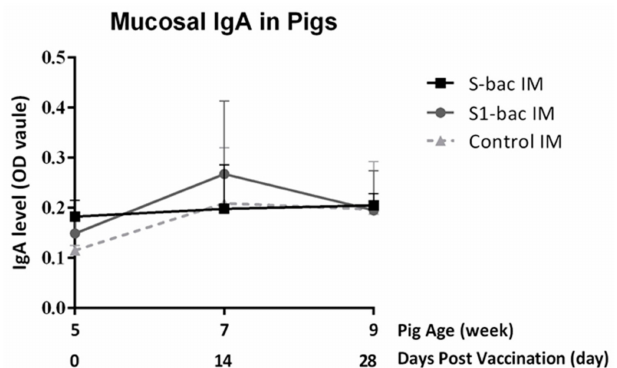
Figure 6. The systemic anti-porcine epidemic diarrhea (PEDV) spike (S)-specific IgG levels in piglets after S-Bac or S1-Bac vaccination. The systemic IgG levels of piglets were detected every two weeks at day 0 (pre-priming), day 14 (2 weeks post-priming) and day 28 (2 weeks post-boosting) by using the PEDV S-based ELISA. The data is shown as the mean values of the sample-to-positive control ratios (S/P ratio), which was defined as the difference between the optical density (OD) values of the sample and the negative control and divided by the difference between OD values of the positive and negative control. The error bars represented the SD values of each group in different time points. The solid line with square icon and the gray line with round icon represent the climbing trend of IgG level in the S-Bac group and S1-Bac group, respectively. The IgG levels in the control group are expressed with the dotted line with triangle icon. *: significant difference with the control group ( p < 0.05).